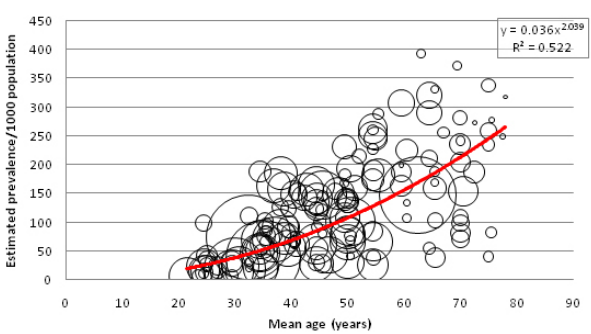
Figure 3. The relationship between crude prevalence of type 2 diabetes in Southern Asia and